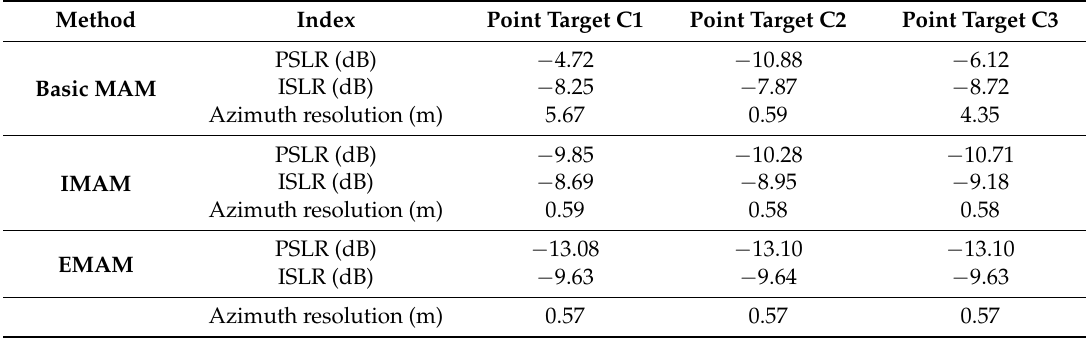
Table 4. The azimuth performance analysis of the three point targets C1, C2, and C3 based on the basic MAM, the IMAM method, and the EMAM method.